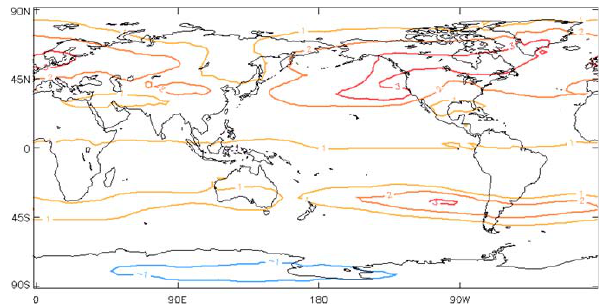
Fig. 5. The difference between the downward radiative fluxes across the tropopause in LEP1 and STD1 (Wm − 2 ) i.e. the impact of the low-entrainment parameter perturbation on the tropopause radiative balance. The contour interval is 1Wm − 2